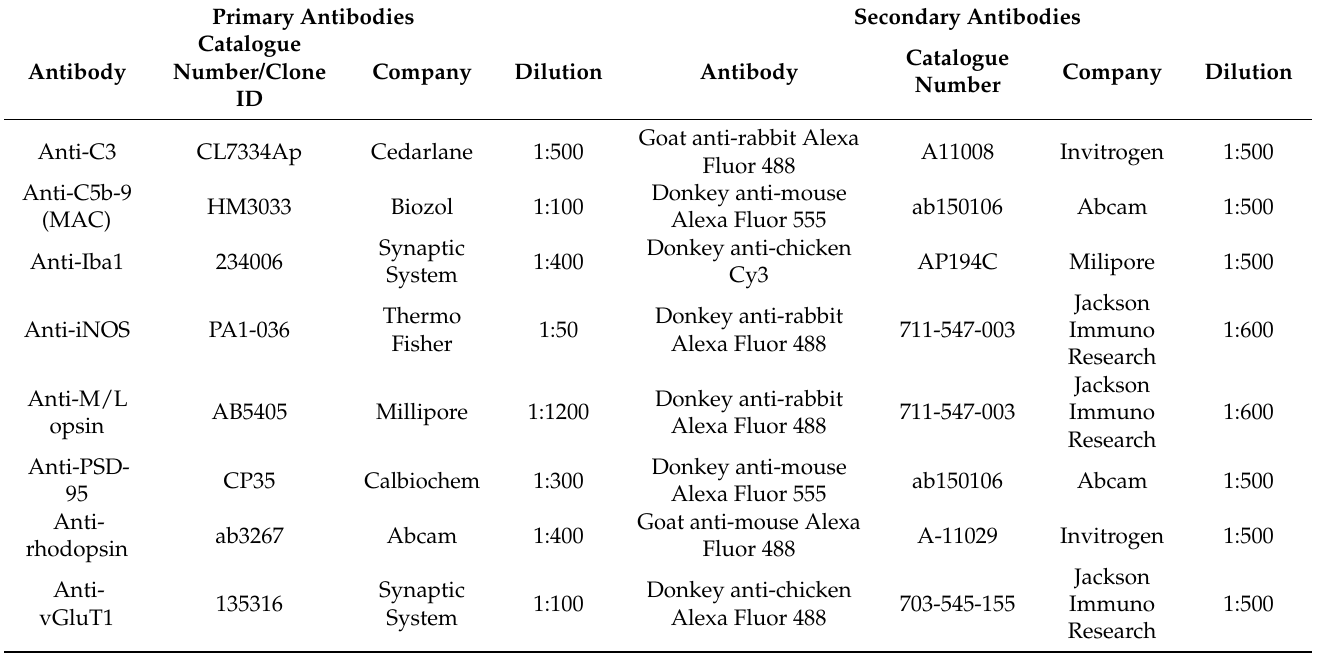
Table 1. List of used primary and secondary